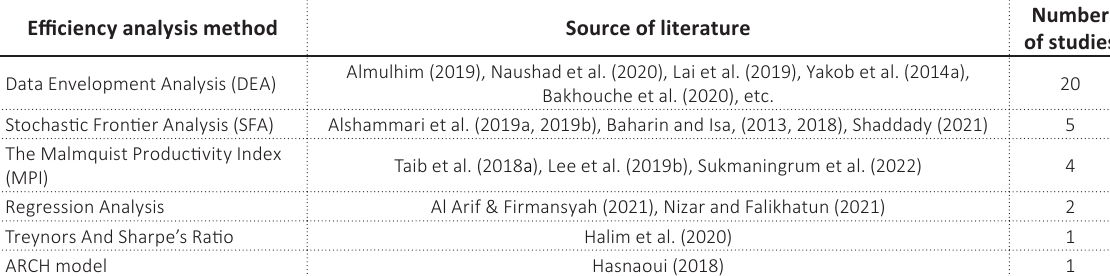
Table 6. Efficiency analysis